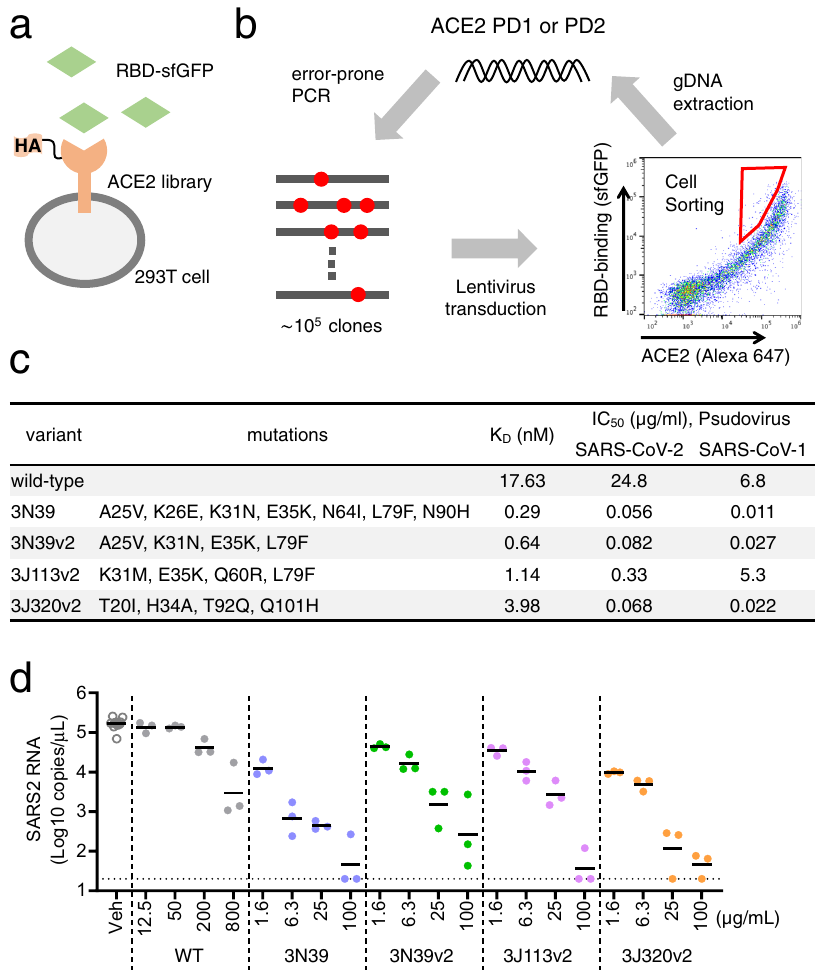
Fig. 1 Directed evolution to generate high af fi nity ACE2 in 293T cells. a ACE2 mutant library was expressed in 293T cells and incubated with the RBD of SARS-CoV-2 fused to superfolder GFP (sfGFP). b Error-prone PCR ampli fi cation of ACE2 protease domain induced random mutations. Mutant library- transduced cells were incubated with the RBD-sfGFP. Top 0.05% population with high level of bound RBD-sfGFP was sorted and underwent DNA extraction, followed by next cycle mutagenesis. Cell sorting was conducted by gating on forward scatter (FSC)-H and FSC-A to exclude doublets, followed by gating on Alexa 647 for HA-ACE2 expression and sfGFP for RBD-binding. c The value of K D and IC 50 against pseudovirus of SARS-CoV-2 and